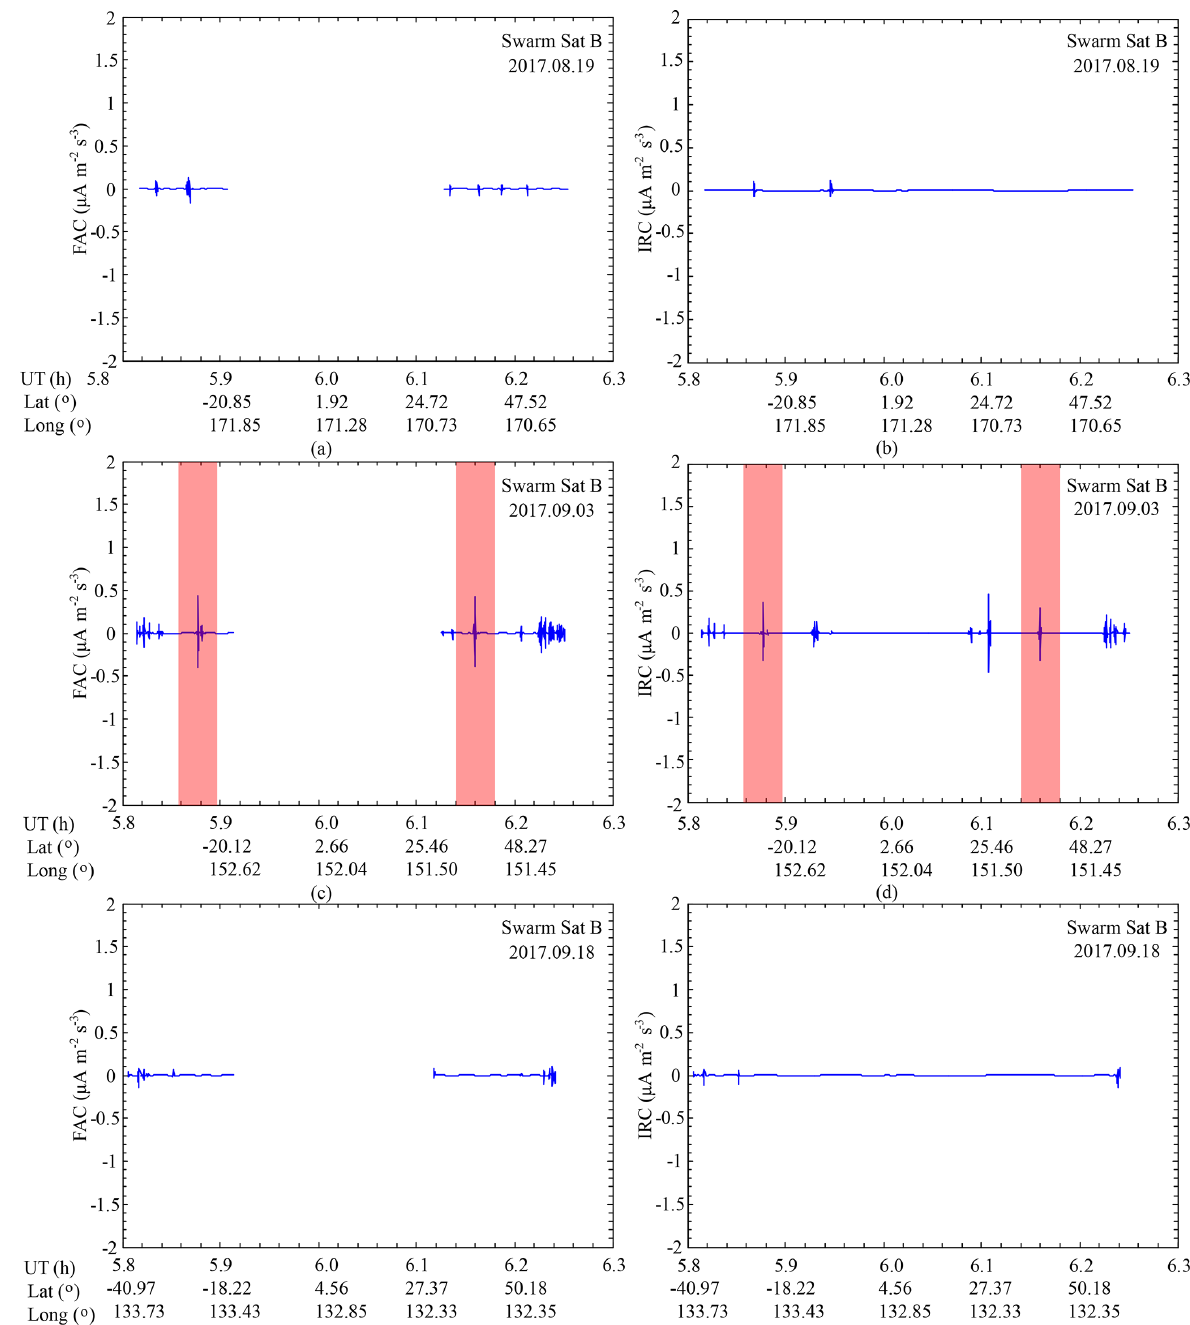
Figure 6. Results of Swarm B ionospheric current data analysis for the 2017 UNE: (a) , (c) and (e) are the FAC; (b) , (d) and (f) are the IRC. From top to bottom, they indicate observations of Swarm B on 19 August 2017 (quiet time), 3 September 2017 (UNE time) and 18 September 2017 (quiet time). The ionospheric current disturbances in response to the UNE are represented by the red